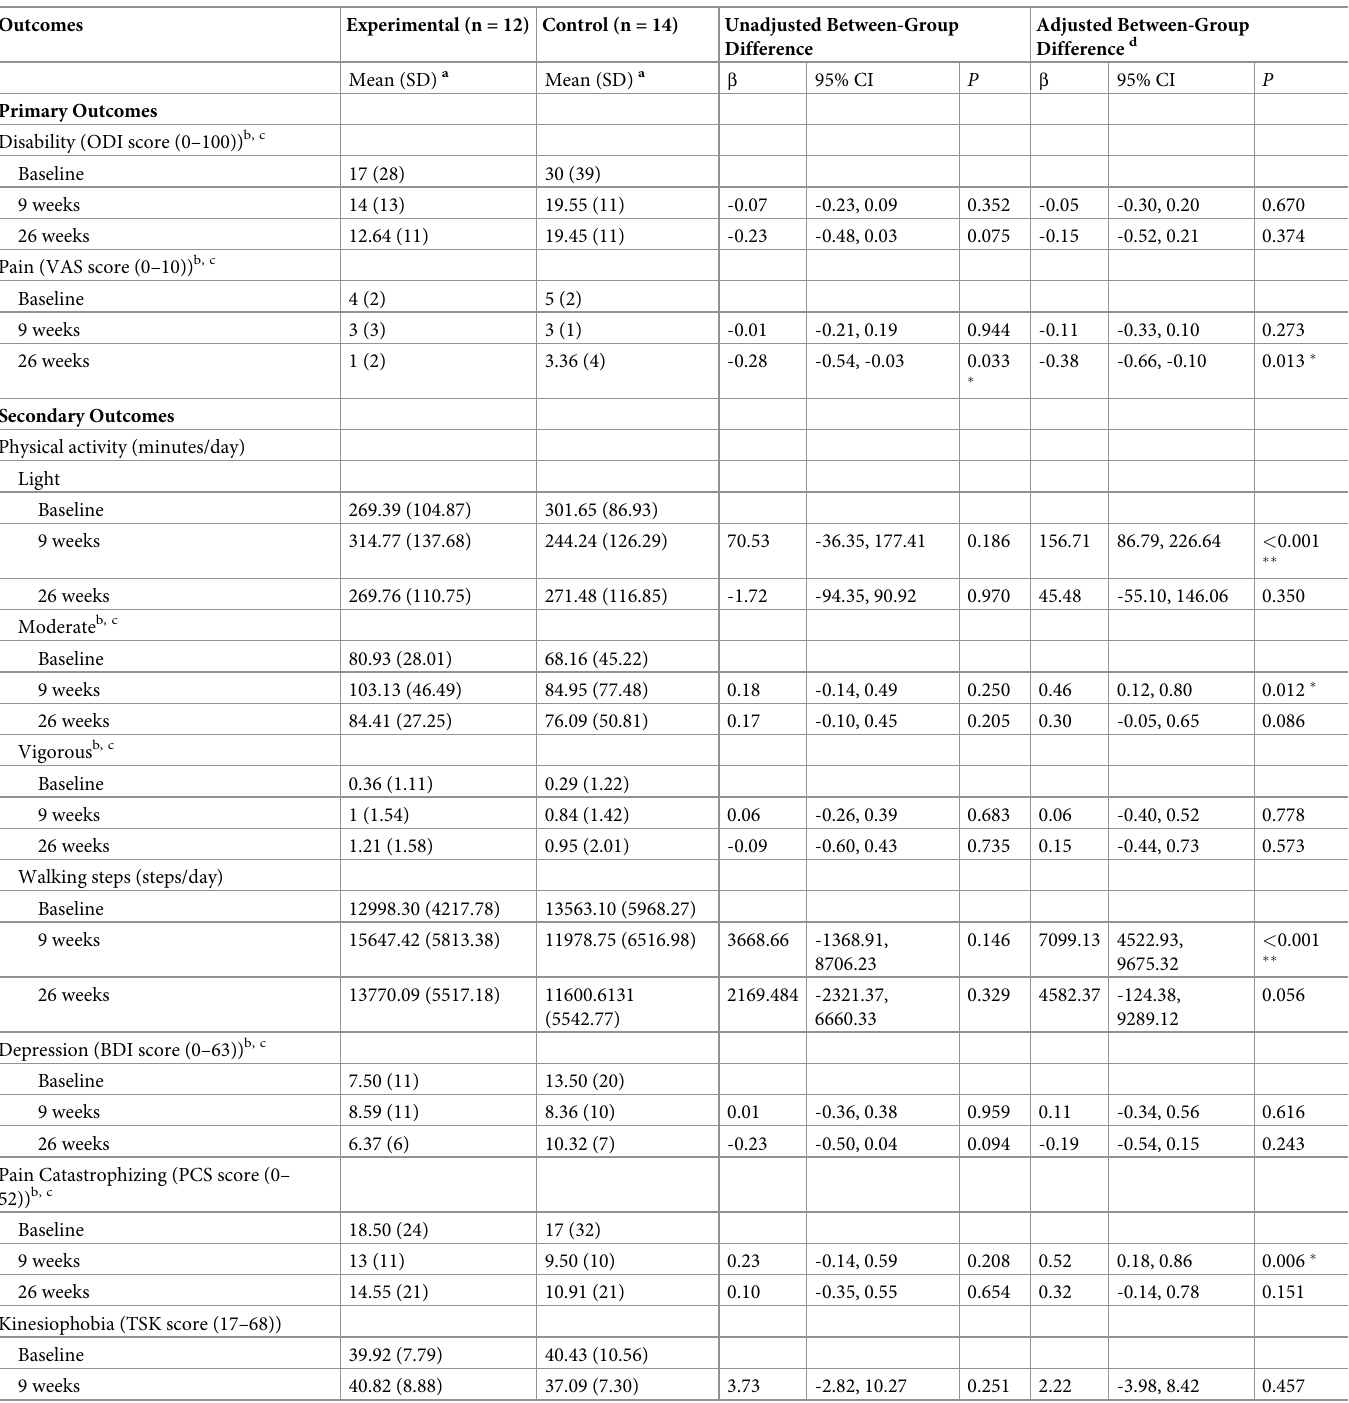
Table 3. Scores for primary and secondary outcomes and differences between